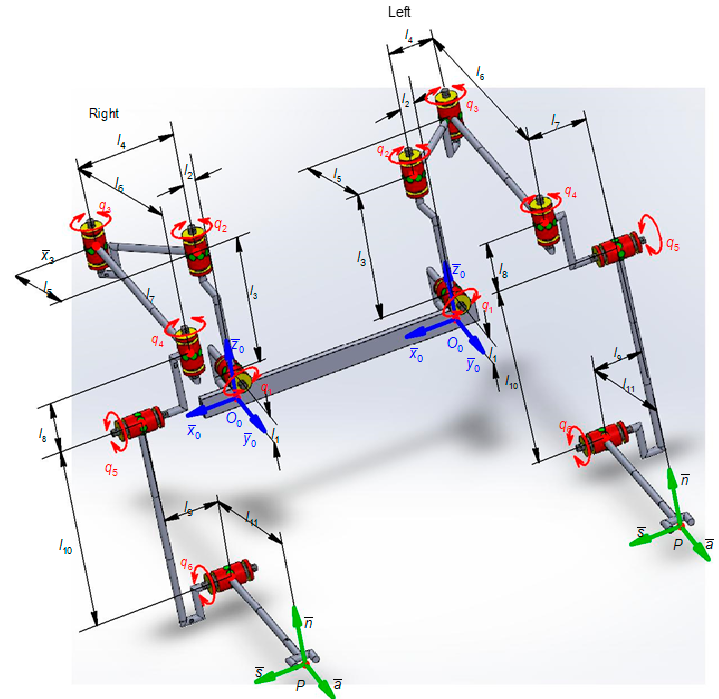
Figure 3. Geometric and kinematic structure of the robotic exoskeleton (6R robot on one arm).